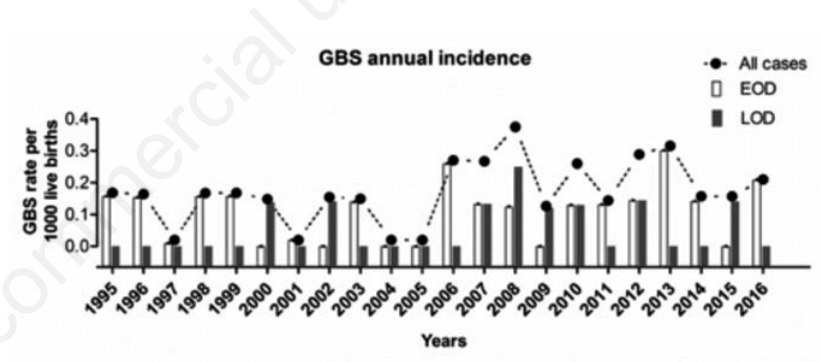
Figure 1. Annual incidence of Group B Streptococcus (GBS) infections in infants less than 90 days of age in Crete, Greece. The rate of all cases of GBS are depicted (circles, black line) as well as the incidence of early onset GBS disease (EOD, white bars) and late onset GBS disease (LOD, gray bars) per each year.